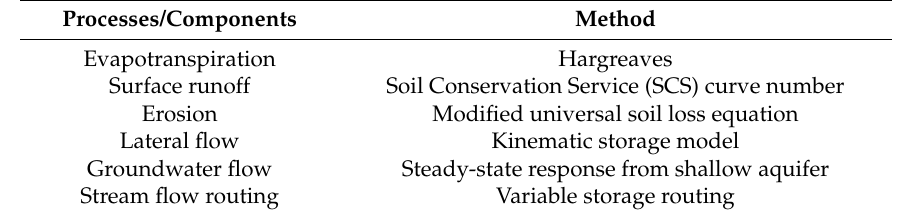
Table 3. Soil and Water Assessment Tool (SWAT) processes used in the study.